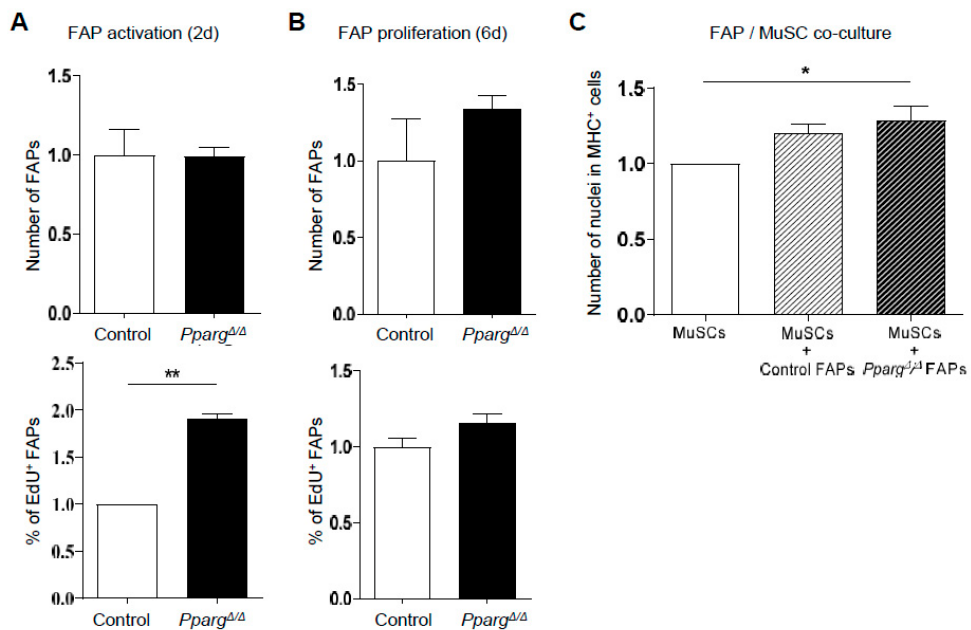
Figure 5. PPAR γ deficiency does not affect the myogenic support of undifferentiated FAPs to MuSCs. ( A , B ) Relative number (top panels) and percentage of Edu-positive FAPs from Pparg ∆ / ∆ and control littermates mice cultured for 48 h ( A ) and six days after isolation ( B , C ) Relative number of differentiated MHC + MuSCs, when cultured alone or co-cultured with Pparg ∆ / ∆ and control FAPs. Data are normalized to MuSCs monoculture. n ≥ 24 cell culture replicates pooled from at least three mice per genotype and replicated twice on different days ** p < 0.01, * p < 0.05 by Mann–Whitney test.